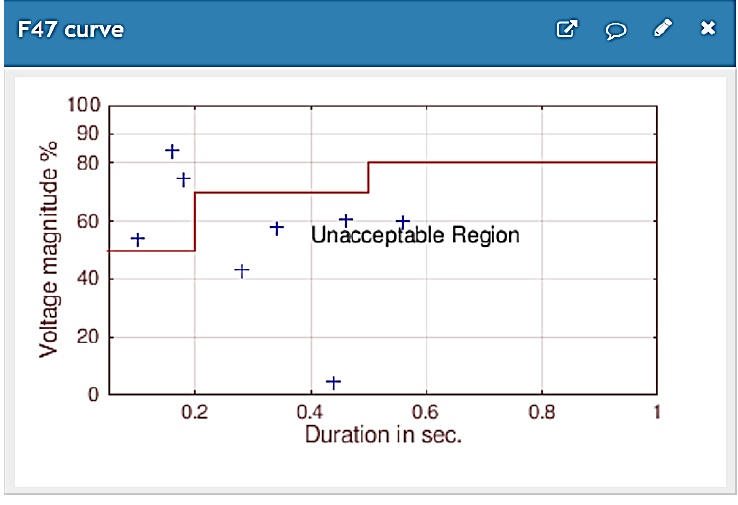
Figure 20. SEMI-F47-curve showing the sags programmed in the experiment.